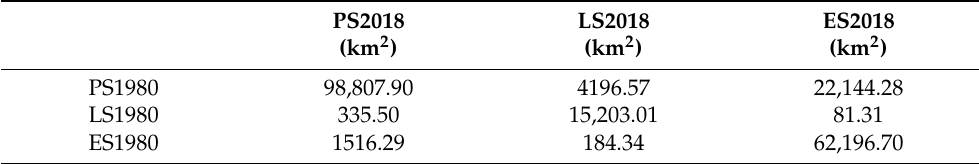
Table 3. PLES transfer matrix from 1980 to